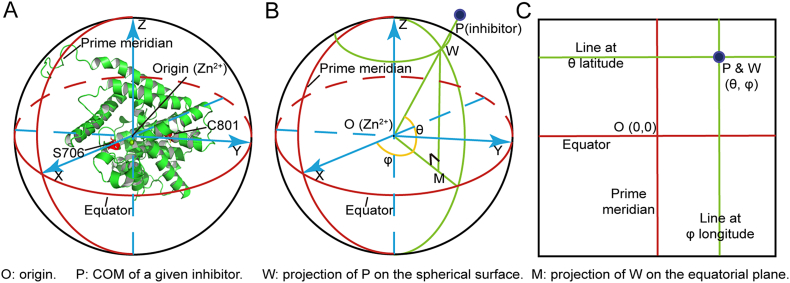
Coordinate systems for constructing the binding free energy landscapes. (A) The spherical coordinate system of PDE2A. (B) The transformation of the spatial coordinates into the geographic coordinates. (C) The unrolled 2D map.